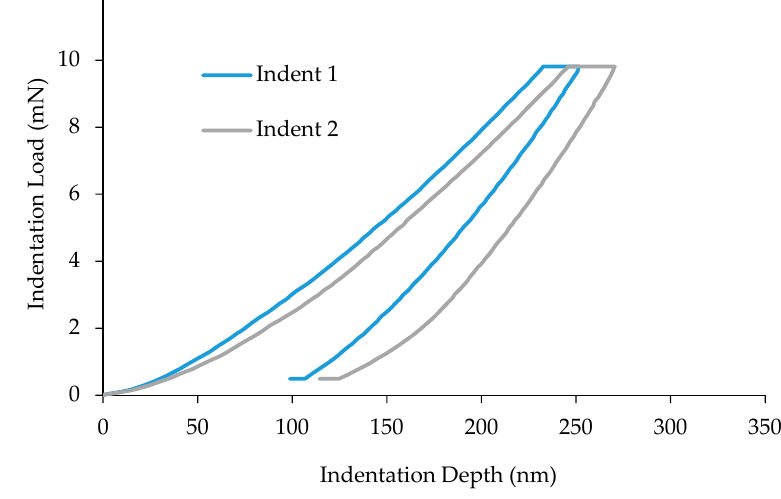
Figure 5. Load-displacement curve for two separate indents on aggregate phase.